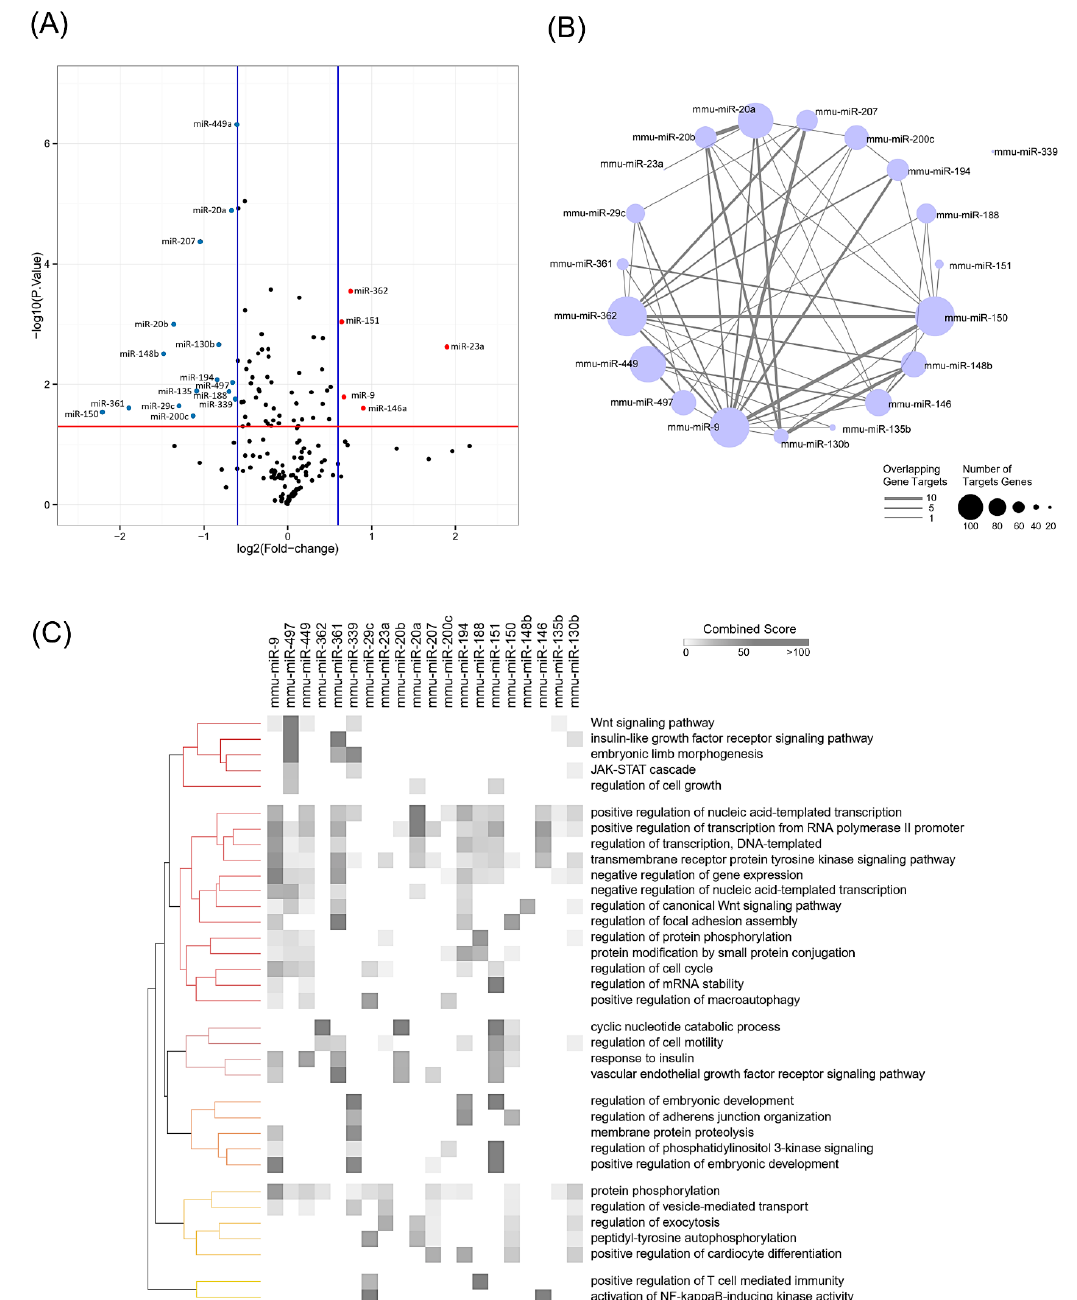
Figure 2. Global miRNA expression in IL-6-treated myotubes. ( A ) Volcano plot representing the log 2 fold change and p -value of all microRNAs differentially expressed. A set of 20 miRNAs displayed significant changes ( p -value < 0.05 and fold change ≥ 1.5). The blue and red dots represent the down- and up-regulated microRNAs, respectively. ( B ) Interaction network representing the 100 interactions between 19 miRNAs and 116 predicted target genes. Node size indicates the number of the miRNA-target gene, and the gray edge width denotes overlapping miRNA-target gene transcripts. ( C ) Heatmap of the biological processes (GO) enriched by a predicted set of targets for each miRNA. The top five ranked annotations of GO and enriched in at least two datasets were included in the heatmap. Unsupervised clustering was performed according to the Kendall rank correlation coefficient.